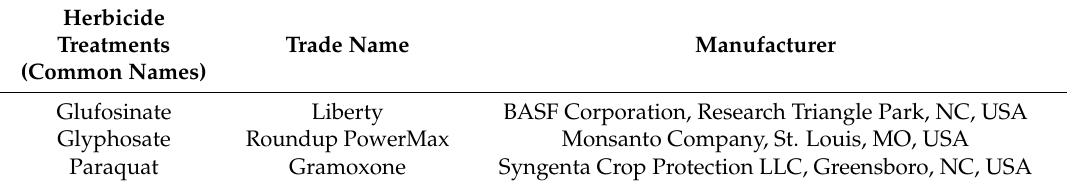
Table 1. Herbicide treatments, trade names, and manufacturers, used in this study in 2017 and